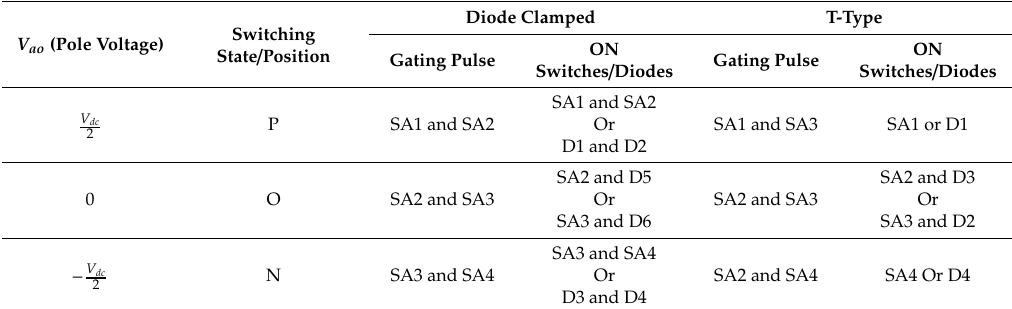
Table 2. Switching states of Diode clamped and T-Type VSI